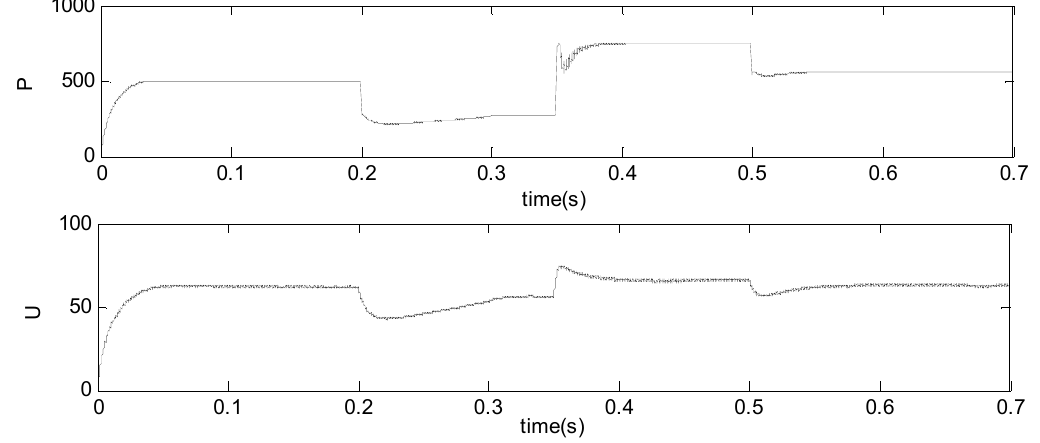
Figure 9. Performance of the proposed MPPT strategy with the FNNGFTSMC scheme.